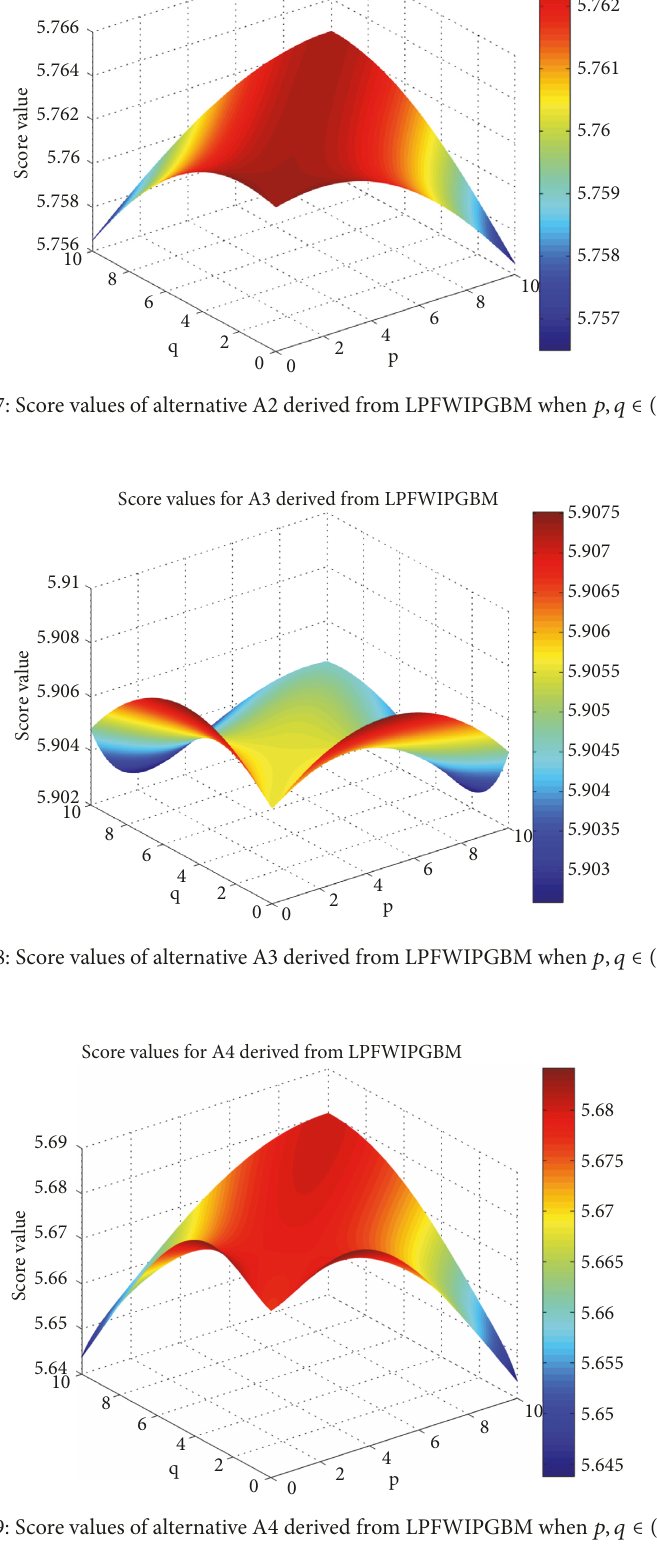
Figure 9: Score values of alternative A4 derived from LPFWIPGBM when 𝑝,𝑞 ∈ (0,10)